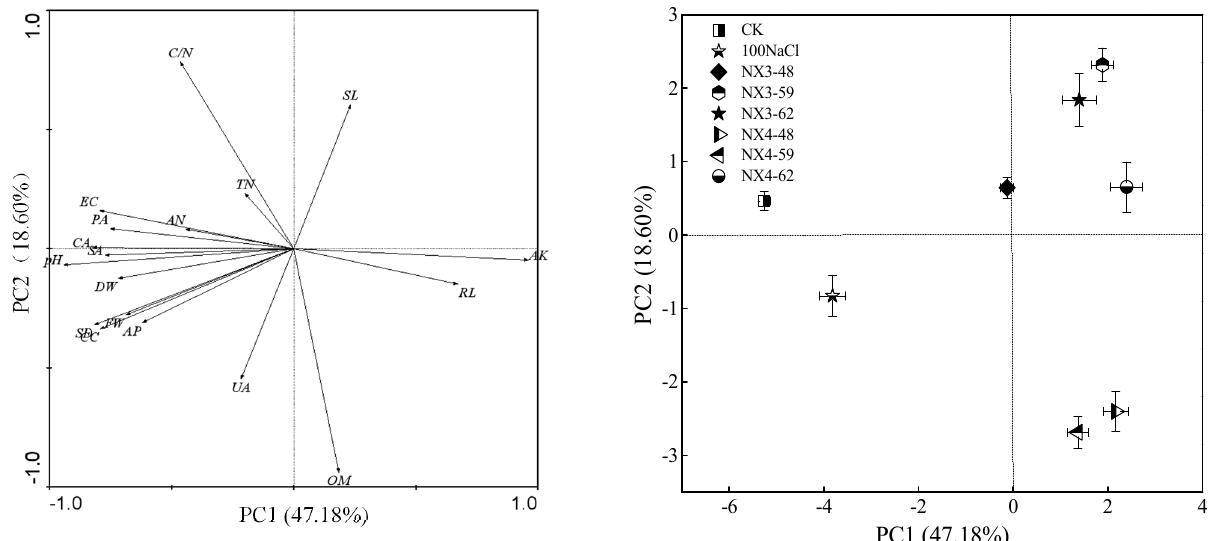
Figure 6. Principal component (PC) analysis of cucumber seedling growth parameters, substrate nutrient properties, and substrate enzyme parameters. Arrow direction and length indicate correlation and strength, respectively. Bars represent standard errors. TN, total nitrogen; AN, available nitrogen; TP, total phosphorous; AP, available phosphorous; AK, available potassium; OM, organic matter; EC, electricity conductivity; C/N; RL, root length; SL, stem length; SD, stem diameter; CC, chlorophyll content; FW, fresh weight, DW, dry weight; CA, catalase activity; SA, sucrase activity; PA, phosphatase activity; UA, urease activity.